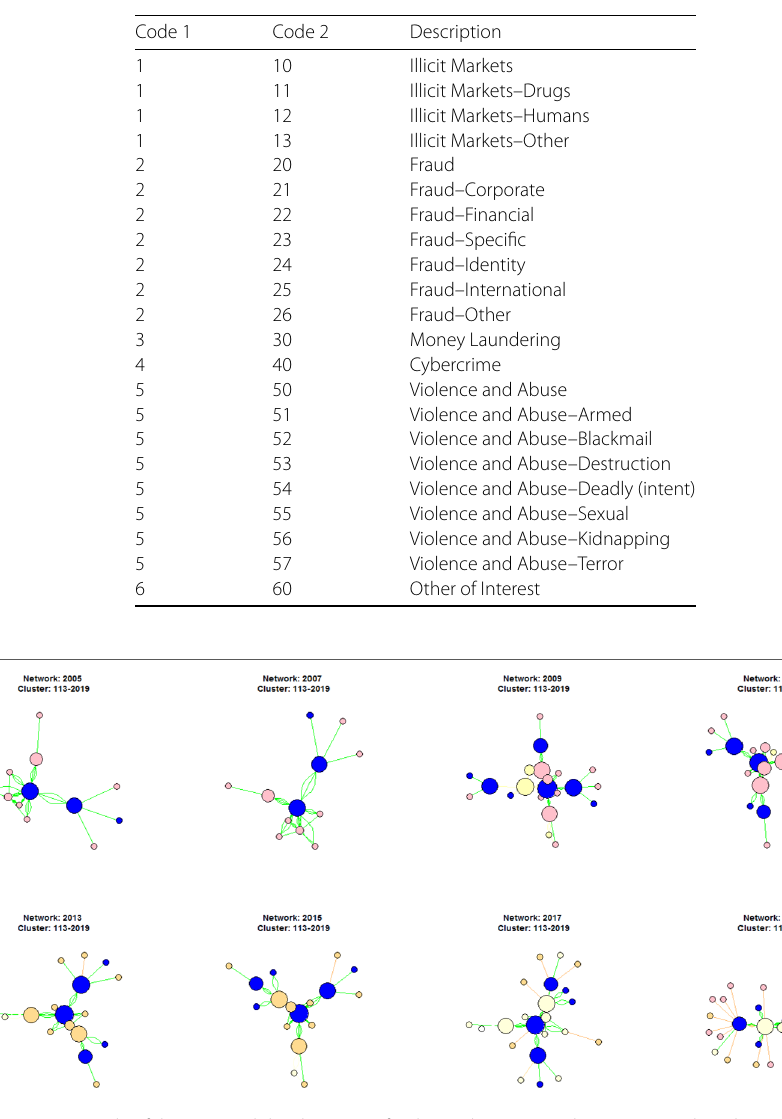
Table 1 Recoded incidents codes from police and justice